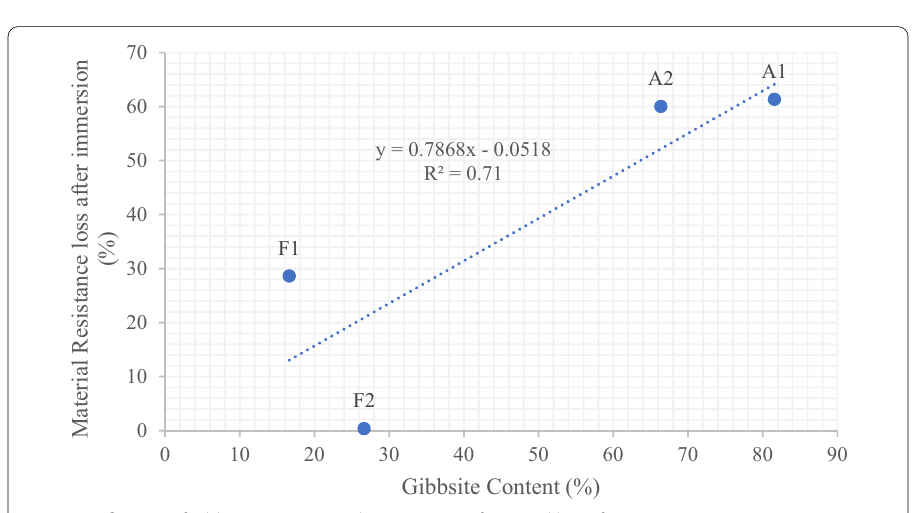
Fig. 12 Influence of gibbsite content on the resistance of material lost after